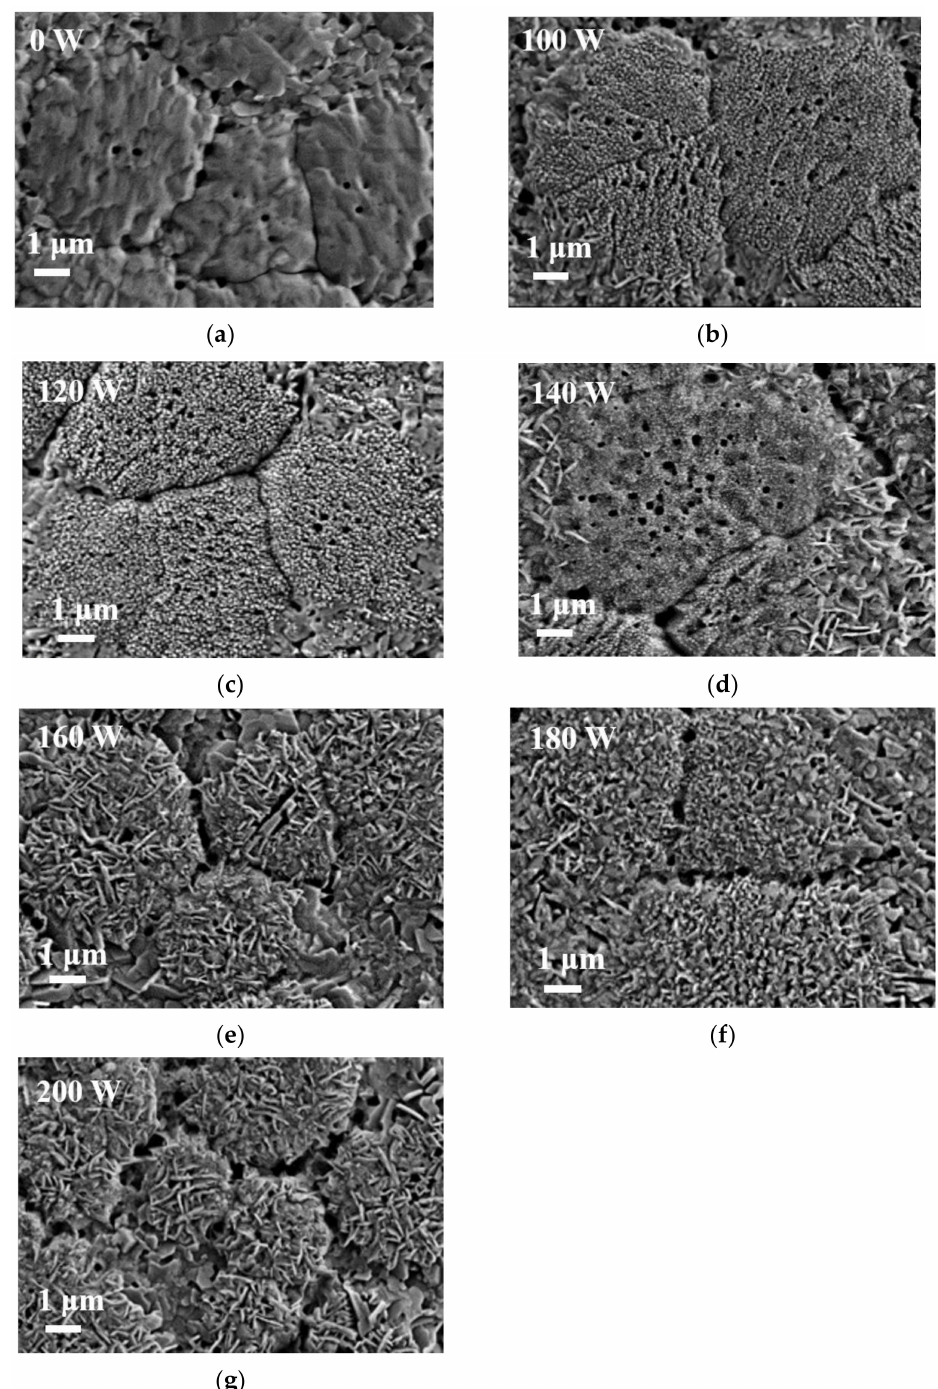
Figure 7. Top-view SEM images of perovskite films composed of MAPbI3 and CsPbI3 QDs treated at different argon plasma powers, from ( a – g ) 0–200